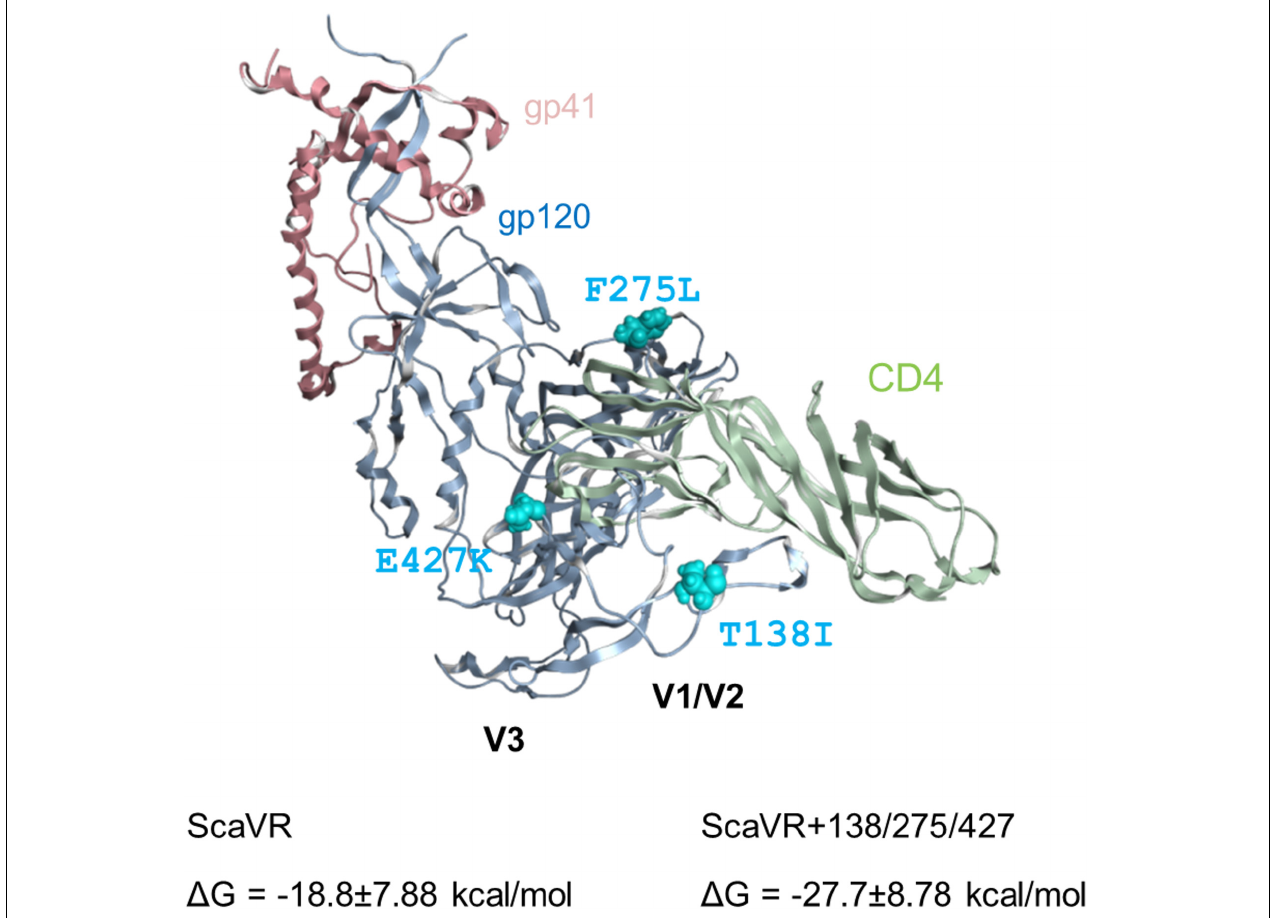
FIGURE 6 | Three-dimensional locations of Env-gp120 mutations in the MD-derived Env ectodomain (gp120 and gp41 ectodomain) bound with soluble CD4. HIV-1 Env ectodomain bound with CD4 was constructed for ScaVR and ScaVR+138/275/427 clones by the homology modeling method using the crystal structure of HIV-1 Env ectodomain with CD4 (PDB code: 5VN3) (Ozorowski et al., 2017). The models were subjected to MD simulations for 500 ns to obtain dynamic structures in solution (see Materials and Methods). Binding energies of the Env proteins to CD4 molecule were calculated using ensembles derived from last 5 ns after 500